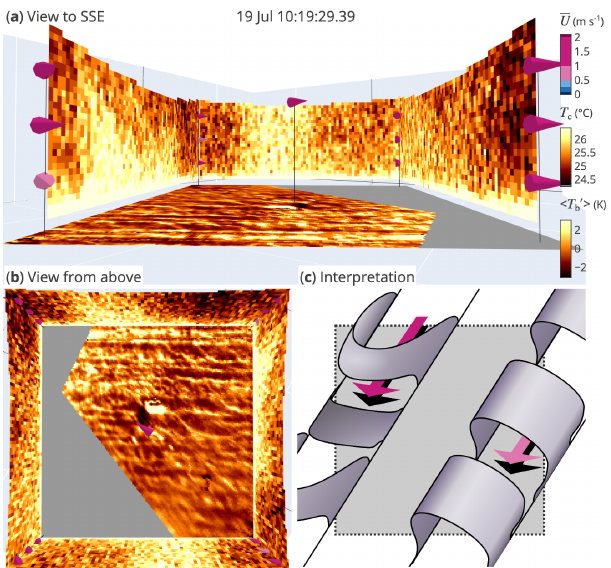
Figure 9. Daytime example of structures and motion in air and surface temperature represented by fibre-optic cable temperature ( T c ) and surface brightness temperature ( T b ) variance, respectively. Shown are (a) a viewpoint from NNW, (b) a perspective from above and (c) a conceptual interpretation. Observations of wind are shown as cones pointing in the direction of the mean wind ( U ).